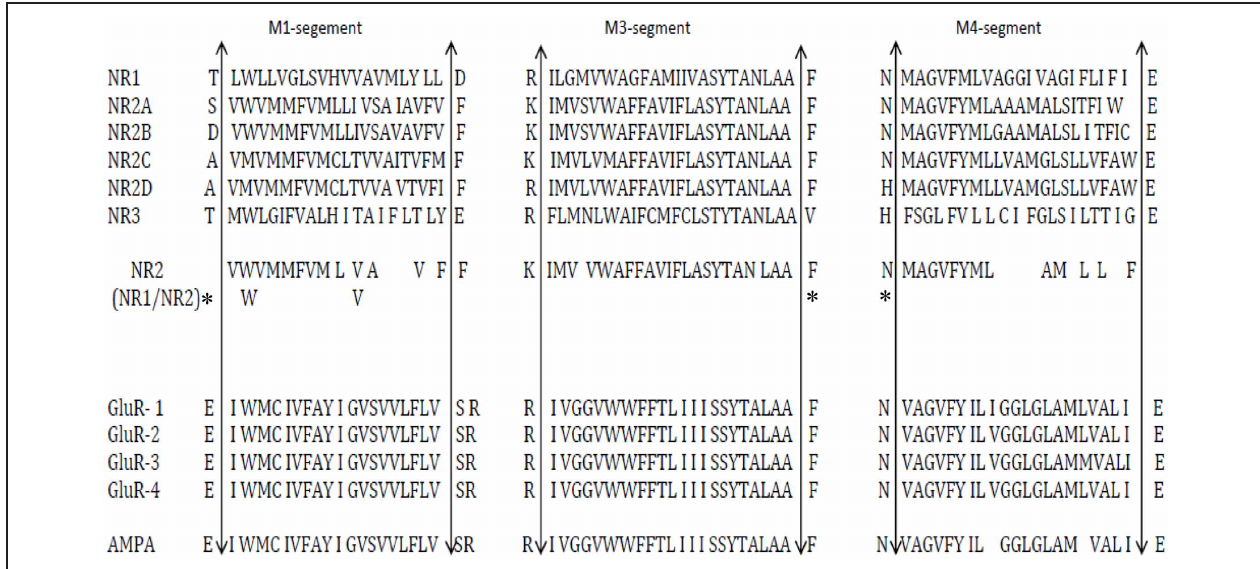
FIGURE 4 | Comparative sequence analysis of the trans membrane domain (M1,M3,M4) region of NMDA receptor subunits, Glu receptor with AMPA. Upward arrow indicates the trans membrane region end; ∗ indicates the consensus residue of NR1/NR2 subunits. [Adapted from Higuera (2009)].